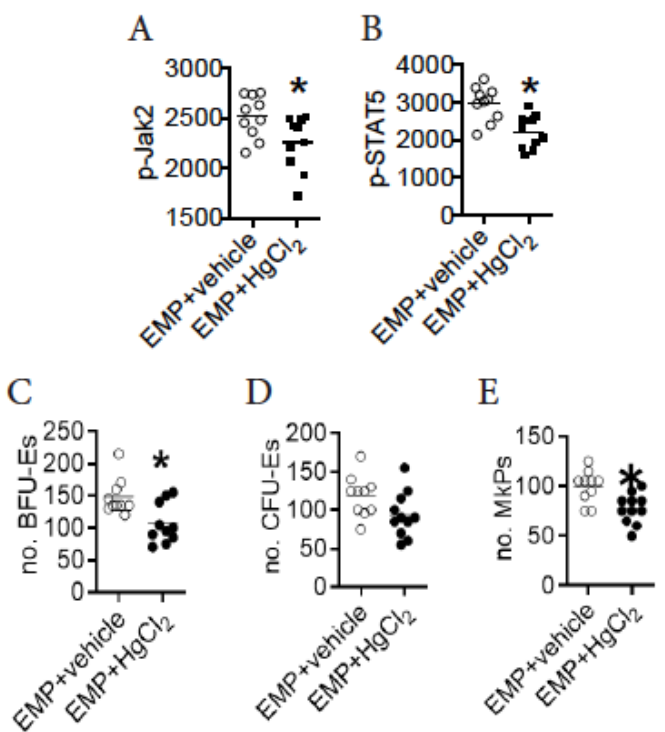
Figure 5. A direct action of HgCl 2 on EMPs suppresses their differentiation in the BM of B10.S mice. FACS-purified EMPs from the BM of B10.S mice were treated with HgCl 2 or the vehicle in vitro for 16 h and the Jak2/STAT5 signaling pathway and differentiation of EMPs into BFU-Es, CFU-Es, and MkPs were measured thereafter. ( A ) The expression of p-Jak2 (MFI) in EMPs. ( B ) The expression of p-STAT5 (MFI) in EMPs. ( C ) The number of BFU-Es in the differentiation assay. ( D ) The number of CFU-Es in the differentiation assay. ( E ) The number of MkPs in the differentiation assay. Each dot represents one mouse, and a total of 10 mice or samples were used for each group. Asterisk indicates a significant difference compared to the counterpart control group. p < 0.05 was considered as the level of significant